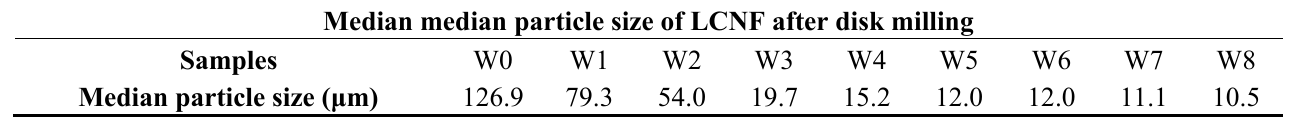
Table 2. Median wood flour particle sizes after disk mill pulverization.